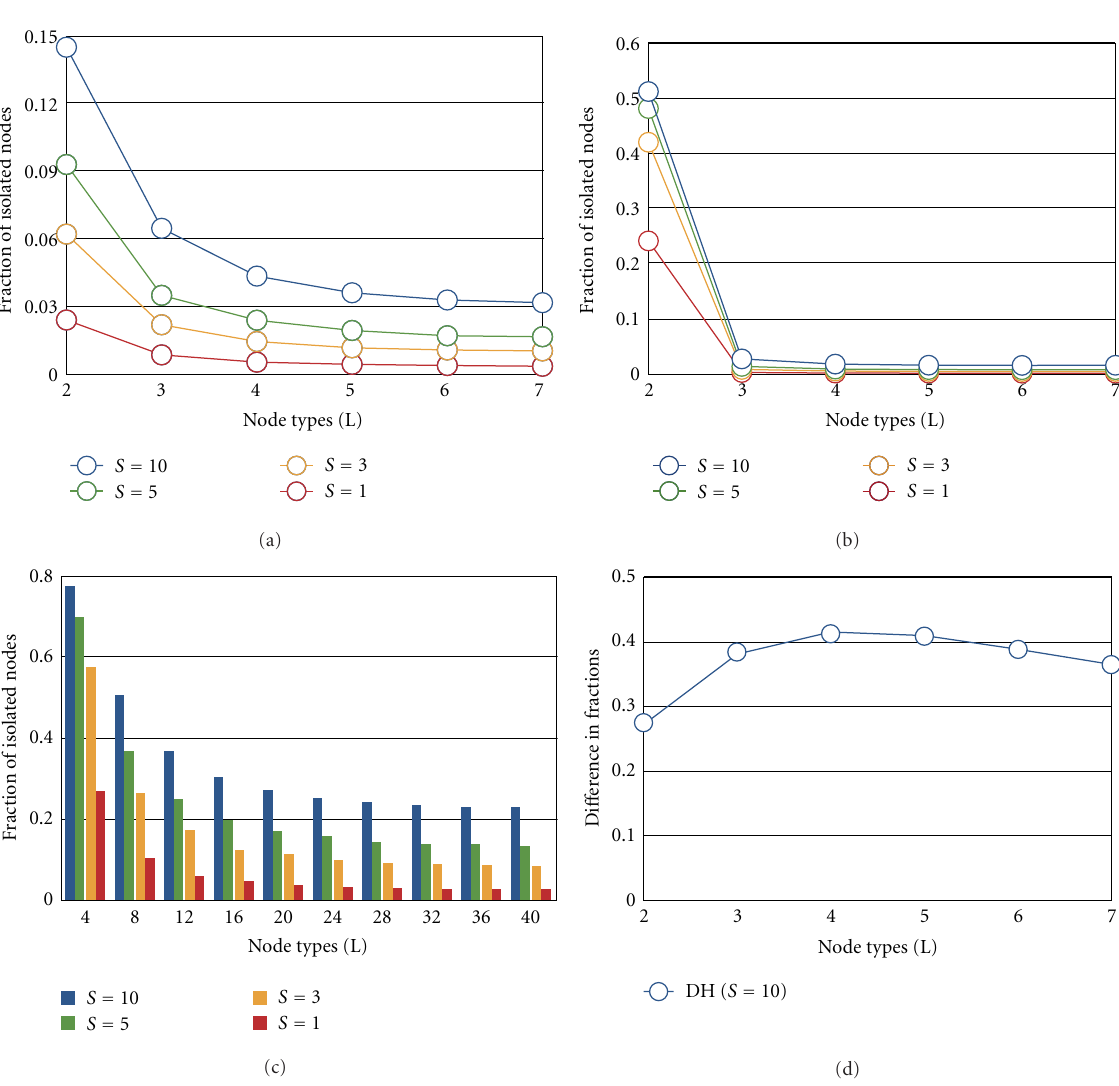
Figure 2: Average fraction of isolated nodes in (a) random BA networks with (cid:2) k (cid:3) = 2; (b) random WS networks with (cid:2) k (cid:3) = 6 and rewiring probability r = 4%; (c) single DH network with (cid:2) k (cid:3) = 4 . 12. (d) Di ff erence between average fractions of isolated and infected nodes for S = 10 in the DH